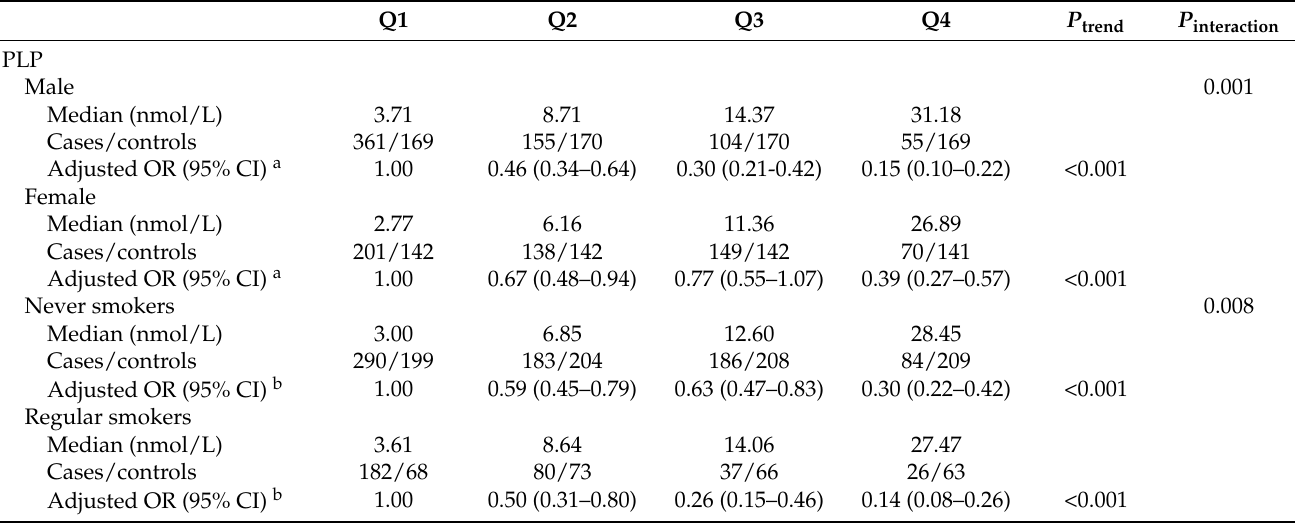
Table 4. Odds ratios and 95% confidence intervals of colorectal cancer according to quartiles of serum PLP, PL plus PLP, and PAr values stratified by sex and smoking